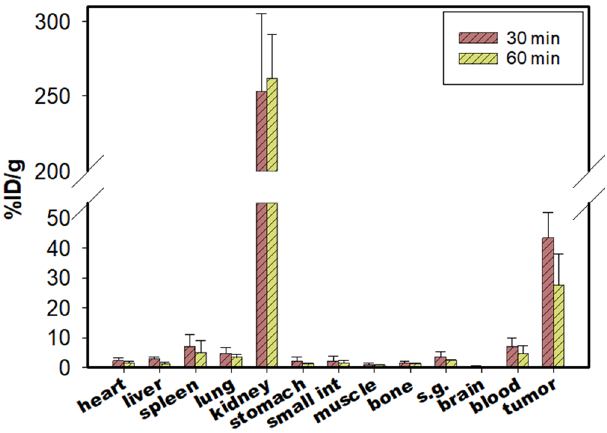
Figure 5. Organ biodistribution of 68 Ga-SC691 expressed as % ID/g tissue at 30 min and 60 min postinjection. Data are expressed as the means ± SD (n = 5). s.g. salivary glands, small int small